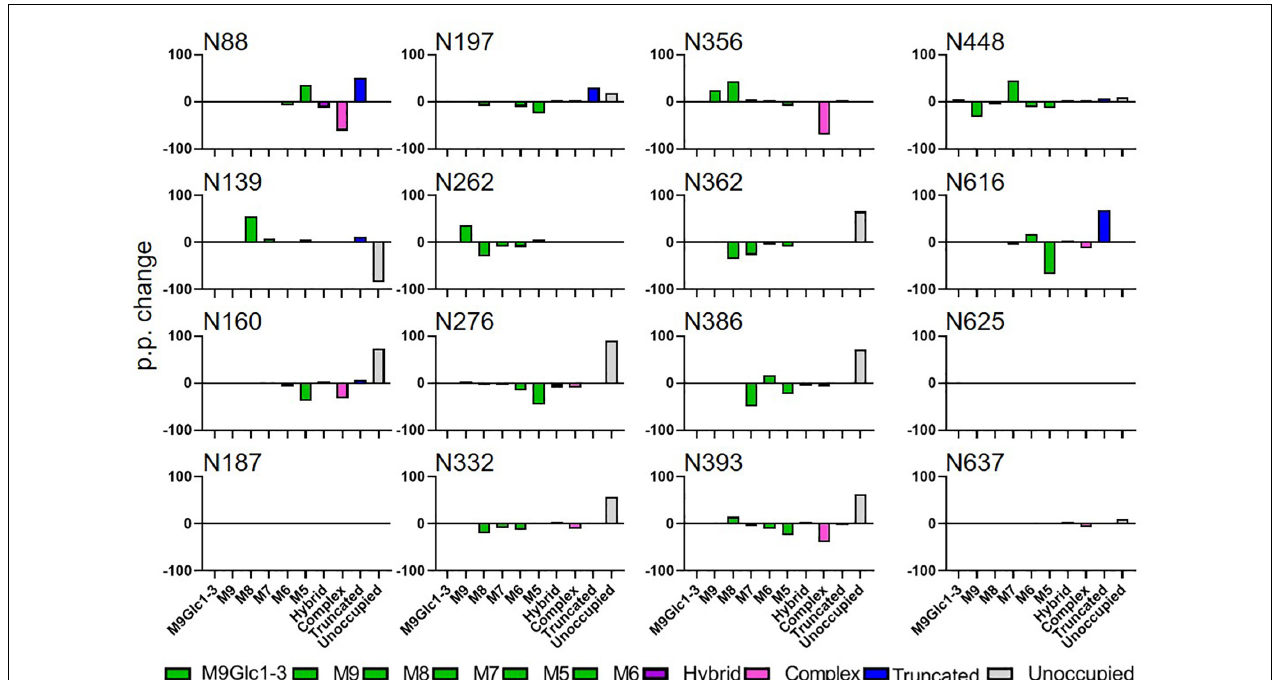
FIGURE 2 | Comparison of site-specific glycosylation of HIV Env gp140 NFL when produce in plants or mammalian cells. The data represent the percentage point change in glycosylation when the protein was expressed in N. benthamiana compared to HEK293, so a positive value represents a category of glycan that is enriched on material produced in N. benthamiana . Glycans are categorized according to the detected compositions by LC-MS. Compositions containing Hex(10-12) HexNAc(2) were categorized as M9Glc1-3 and Hex(9-5) HexNAc(2) as M9-M5. These are classified as oligomannose-type glycans and are colored green. Hybrid-type glycans contain compositions consisting of Hex(5)HexNAc(3)X or Hex(6)HexNAc(4)X. Remaining glycan compositions were assigned as complex-type. Any composition Hex(3) HexNAc(2) or smaller is classified as truncated. The proportion of potential N-linked glycans which are classified as unocupied are coloured